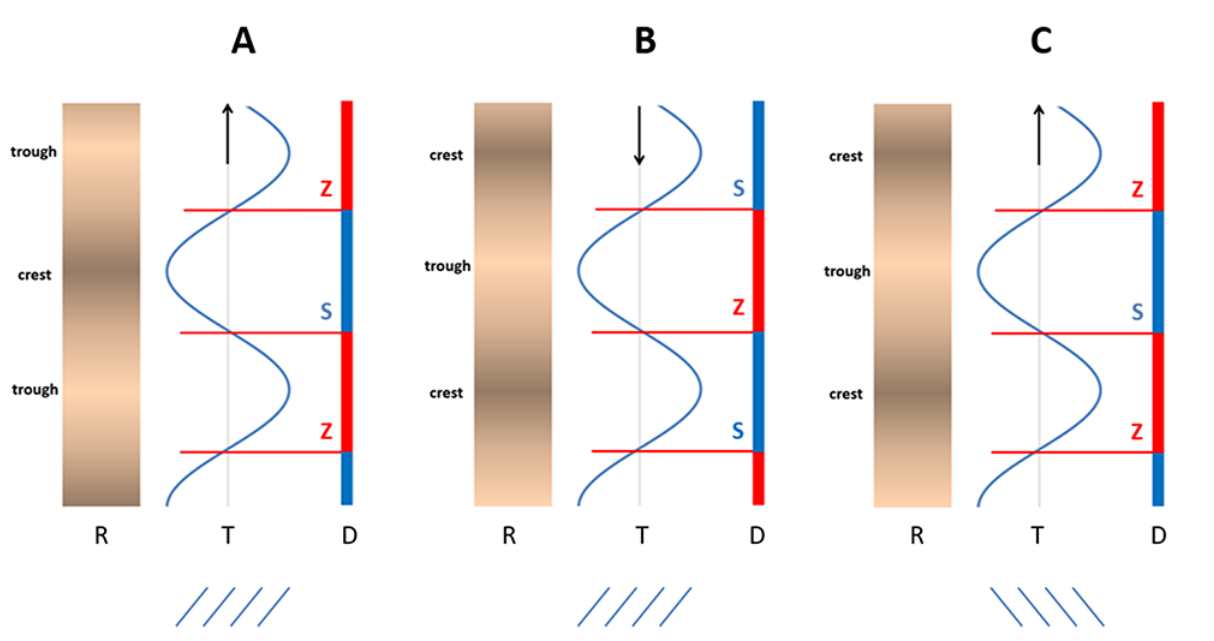
Figure 8 e relationship between the radial wave (R), the tangential wave (T), and the cambial domain pattern (D) in three variants ( A–C ) found in this study. All patterns are shown en face; ( A ) the most common variant, in which the patterns move upward and the grain course changes in a Z/S vertical sequence; ( B ) the less frequent variant, in which the patterns move downward, opposite to what happens in ( A ). Both ( A ) and ( B ) variants occurred when ripples were Z inclined; ( C ) a unique variant associated with S-inclined ripples. e borders between consecutive cambial S (blue) and Z (red) domains are at the levels of maximum inclination of wood grain within the T-wave. Arrows show the direction of synchronized movement of all patterns.